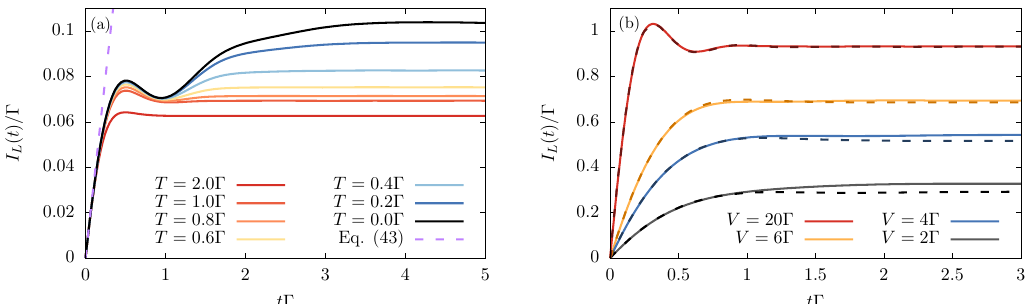
( t ) for U = 8 Γ , ε = − U / 2, V = Γ and several L = |↑〉〈↑| . (b) Transient current 0